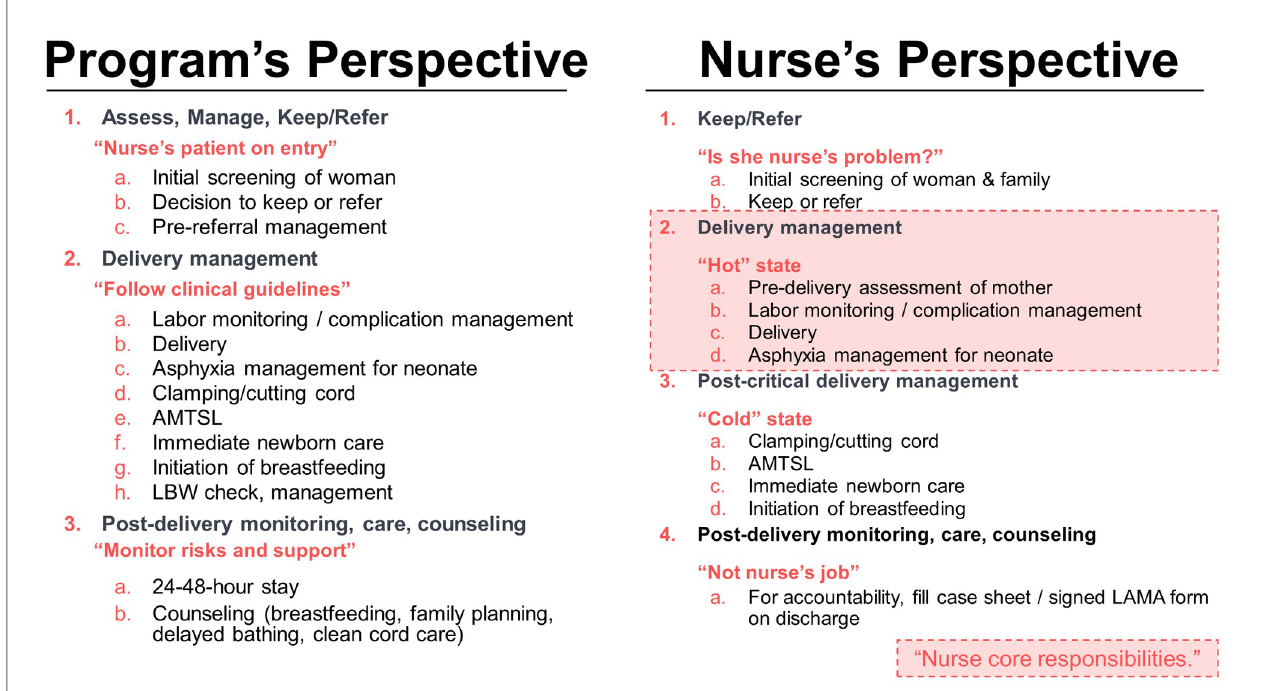
Fig 7. Program and staff perception of the nurse role. Programs and staff nurses perceive the role of the nurse differently, resulting in a gap between program expectations and actual